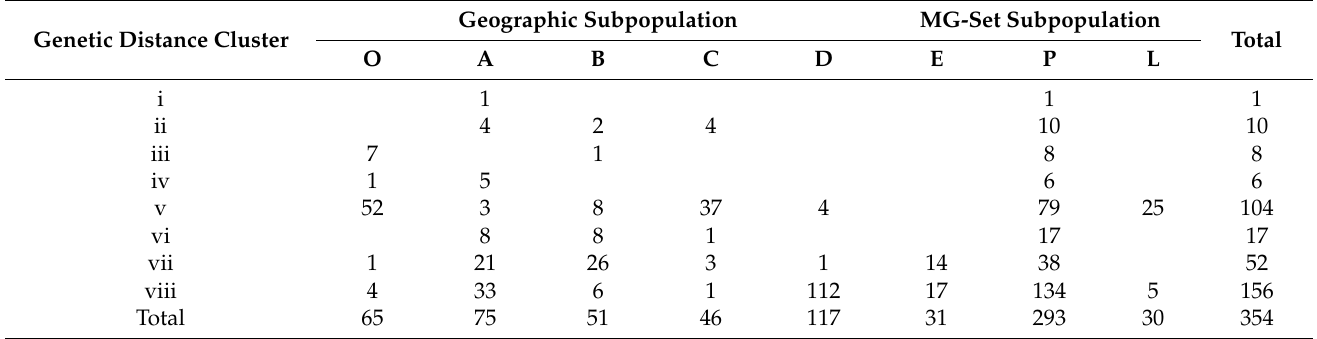
Table 4. The frequency distribution of geographic and MG-set subpopulations in 8 genotypic clusters of world soybean germplasm population